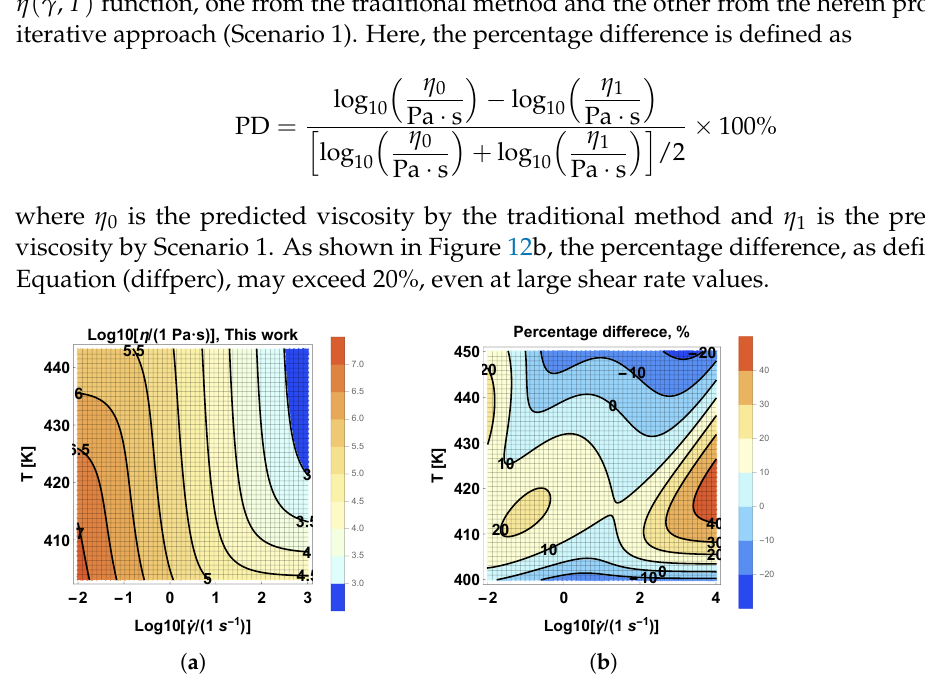
Figure 12. Viscosity vs. shear rate vs. temperature contour plots by the parameters from ( a ) Scenario 1 and ( B ) the percentage difference between Scenario 1 and traditional